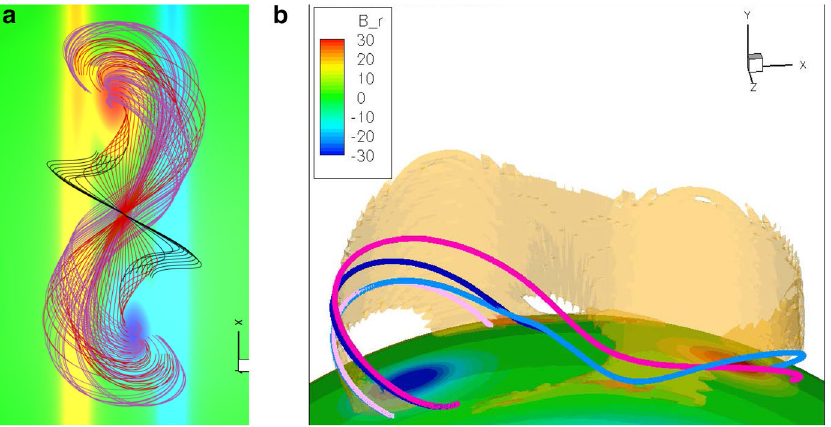
Fig. 9 Equilibrium magnetic flux rope model and sigmoidal separatrix. a Demonstration of the oppositely directed field-line orientations relative to the PIL manifested at the bottom versus top of a right-handed helical flux rope. Magenta field lines represent the bald-patch-separatrix surface (BPSS) and trace out the bottomofthehelixasitgrazesthephotosphere,whileblackfieldlinesrepresenttheoppositelyorientedfield lines at the top of the flux rope (after Fan 2017). b Current sheet (isosurface) that forms under dynamic (but not eruptive) perturbation, leading to interchange reconnections between BPSS (light-blue) and adjacent arcade(dark-blue)fieldlinesandresultinginreconnectedsigmoidal/arcadefieldlines(darkpink/lightpink). Image reproduced with permission from Gibson and Fan (2006a), copyright by AGU